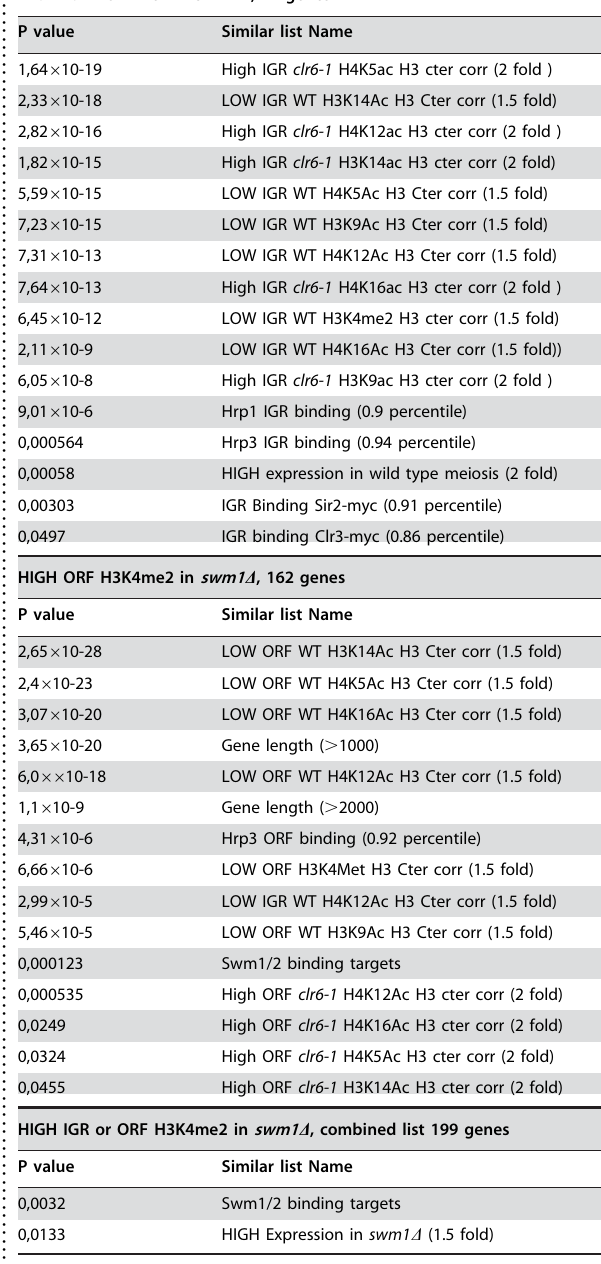
Table 1. Hyper-geometric probability comparisons of genes either down- or up-regulated in swm1 deletion cells. .. ... .... ... ... .... ... ... .... ... ... .... ... ... .... ... ... .... ... ... .... . HIGH Expression in swm1 D vs wild-type, cut-off 1.5 (3 of 4), 265 genes